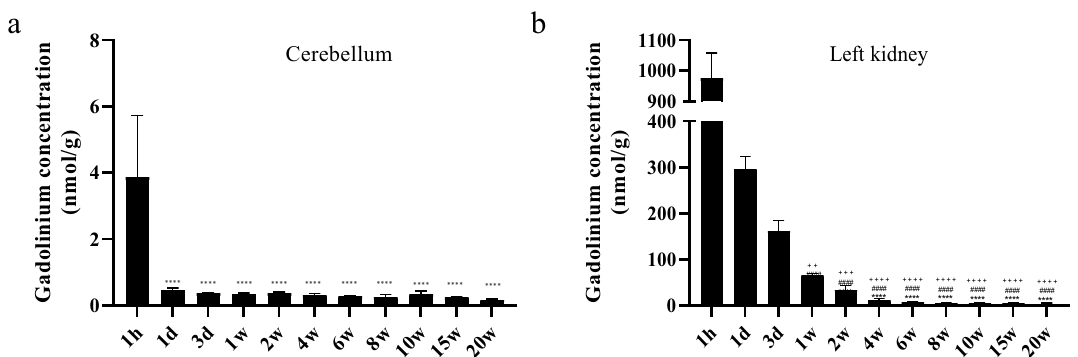
Figure 5. Gadolinium concentrations in the whole cerebellum and left kidney after a single gadodiamide administration. ( a ) Gadolinium concentrations in whole cerebellum shows initial rapid clearance and a slower reduction in gadolinium over 20 weeks after a 0.6 mmol/kg administration in rats. ( b ) Kidney gadolinium concentrations demonstrate triphasic clearance with initial rapid clearance up to one-day, a slower clearance up to 2 weeks and a plateau up to 20 weeks after a single administration of gadodiamide. Graphs show mean ± SD (n = 3 per time point). Statistical analyses using a one-way ANOVA with a Dunnet’s post-hoc test, p ≤ 0.01 ++ , < 0.001 +++ , < 0.0001**** /####/++++ . The significance level of each comparison is indicated for each column when compared to 1 h (*), 1 day (#) or 3 days ( +) time 50 weeks post administration. These results suggest that a human equivalent dose of gadodiamide results in no neural tissue damage or abnormalities and is washed out from tissues over time. These data show for the first time the kinetics of a single administration of gadodiamide in rats in a panoply of tissues and discrete brain regions, demonstrating that whilst there are varying degrees of retention in tissues, Gadolinium levels diminish up to 20 weeks after administration in the majority of tissues. This is important with regards to existing literature and